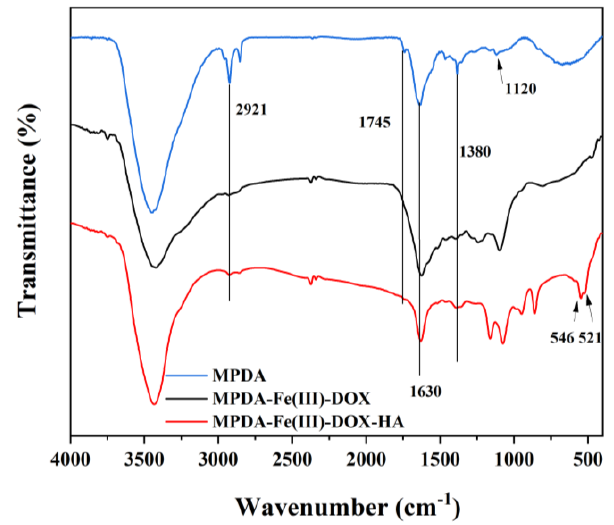
Figure 5. Comparison of the IR spectra of nanoparticles at different steps.